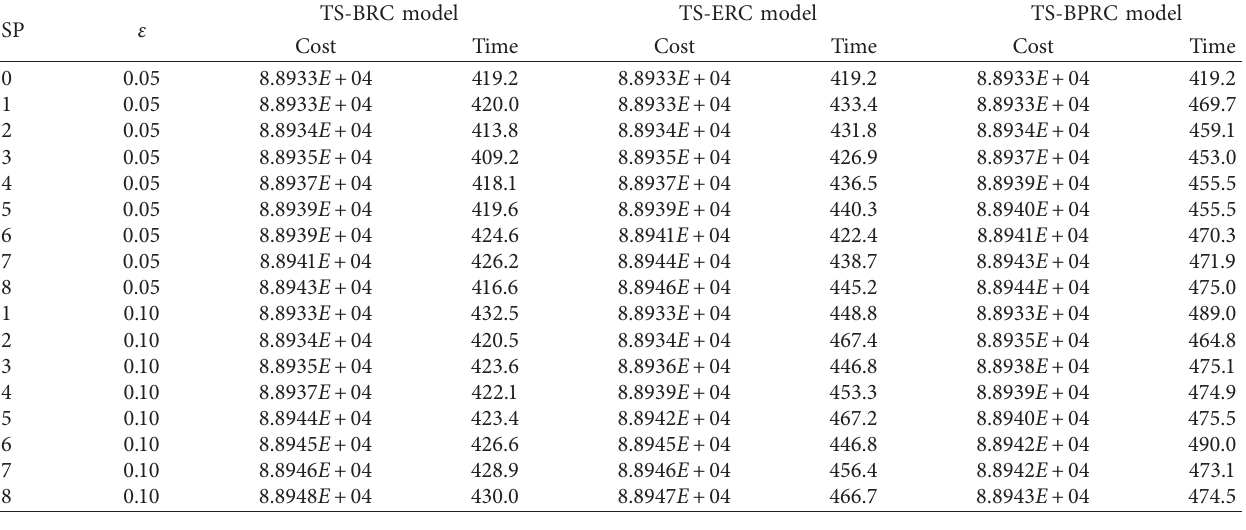
Table 5: Results of TS-RC model.